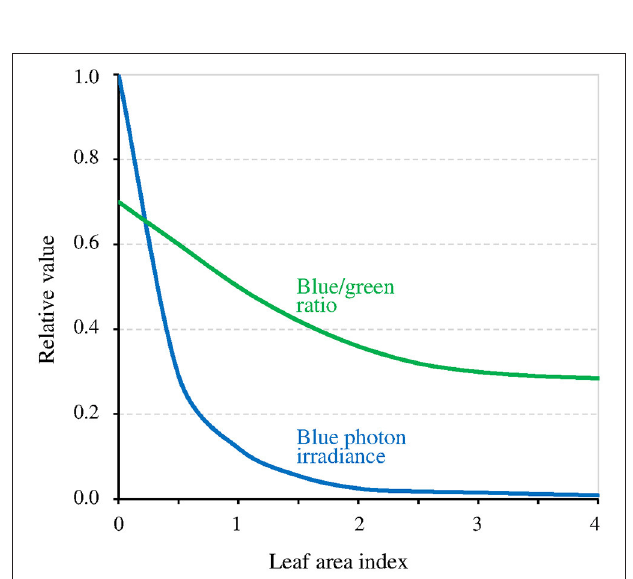
FIGURE 5 | Relative value of blue light intensity and of the blue/green ratio as a function of the density of the canopy coverage expressed as the leaf area index (an index of 1 corresponds to a single layer of leaves) (adapted with permission from Sellaro et al., 2010, © American Society of Plant Biologists). current situation differs from that in the northern one ( Figure 7 ).